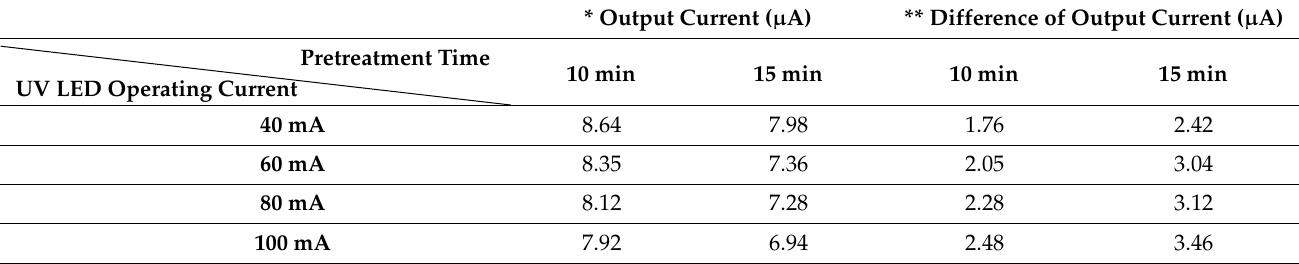
Table 2. Output current and difference output current as a function of the pretreatment time and the UV LED operating current. (The TP concentration of the used analyte was 2 mg/500 ml. The difference of the output current was calculated by differencing the output current between the DI (without phosphorus) and the analytes (with phosphorus).)